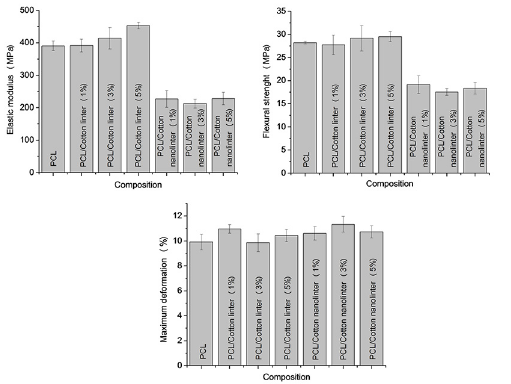
Figure 7: Mechanical properties in flexion: Elastic modulus, Tensile strength and Elongation at break of PCL, and PCL/cotton linter and PCL/cotton nanolinter compounds. Compositions indicated.